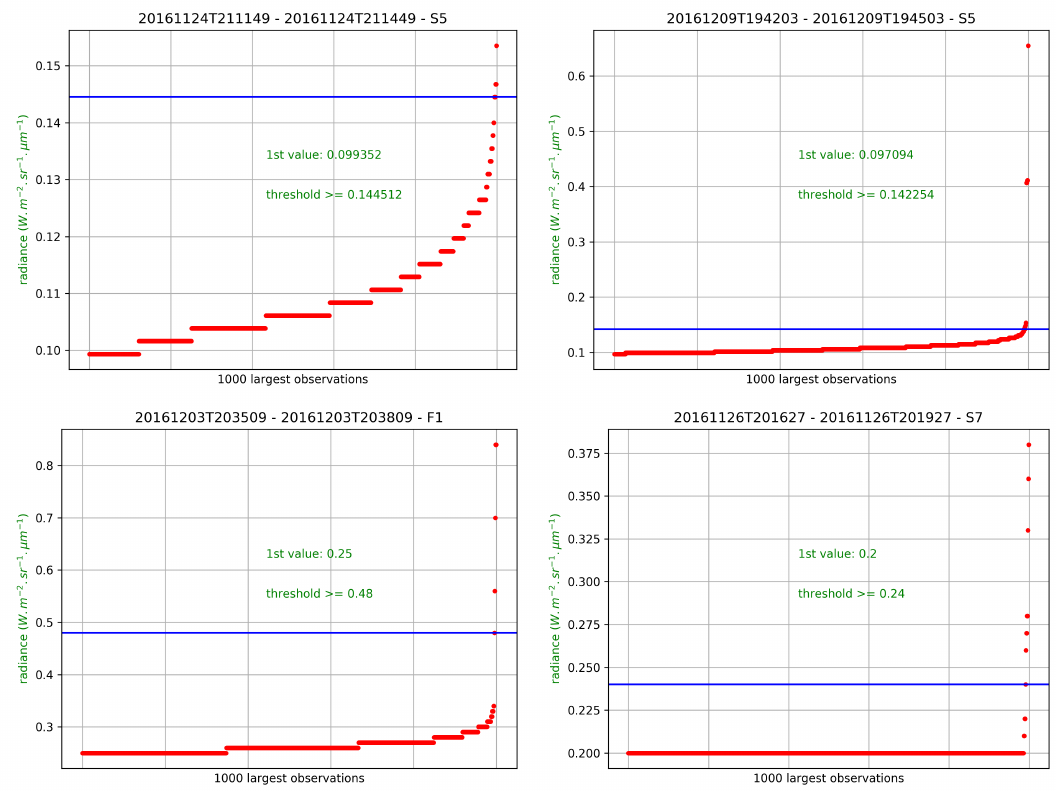
Figure 4. Four examples of thresholding for the S5 band. The horizontal line marks the threshold value. The threshold is set contextually as the lowest radiance value whose difference to the closest inferior radiance value is larger than the scale